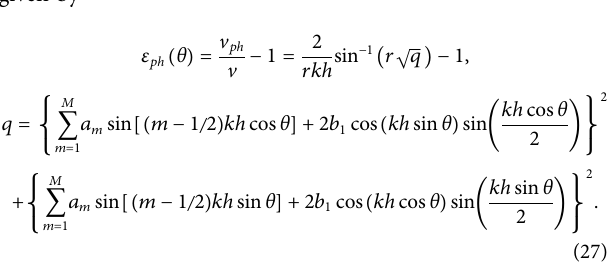
Frontiers in Earth Science |